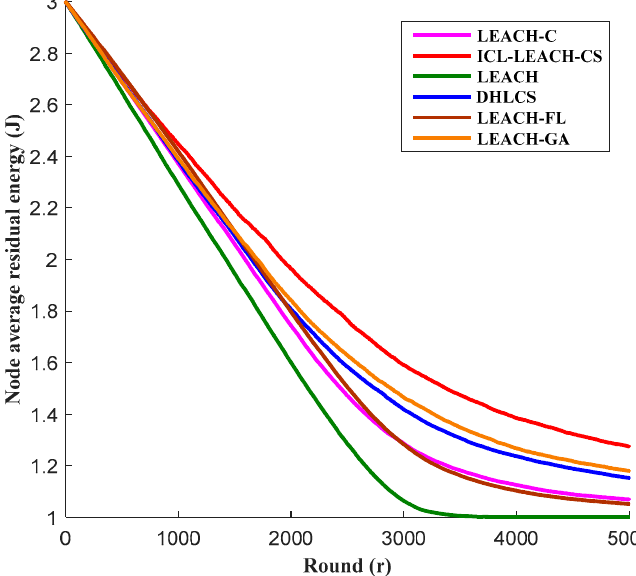
Figure 11. Node average residual energy vs. round.